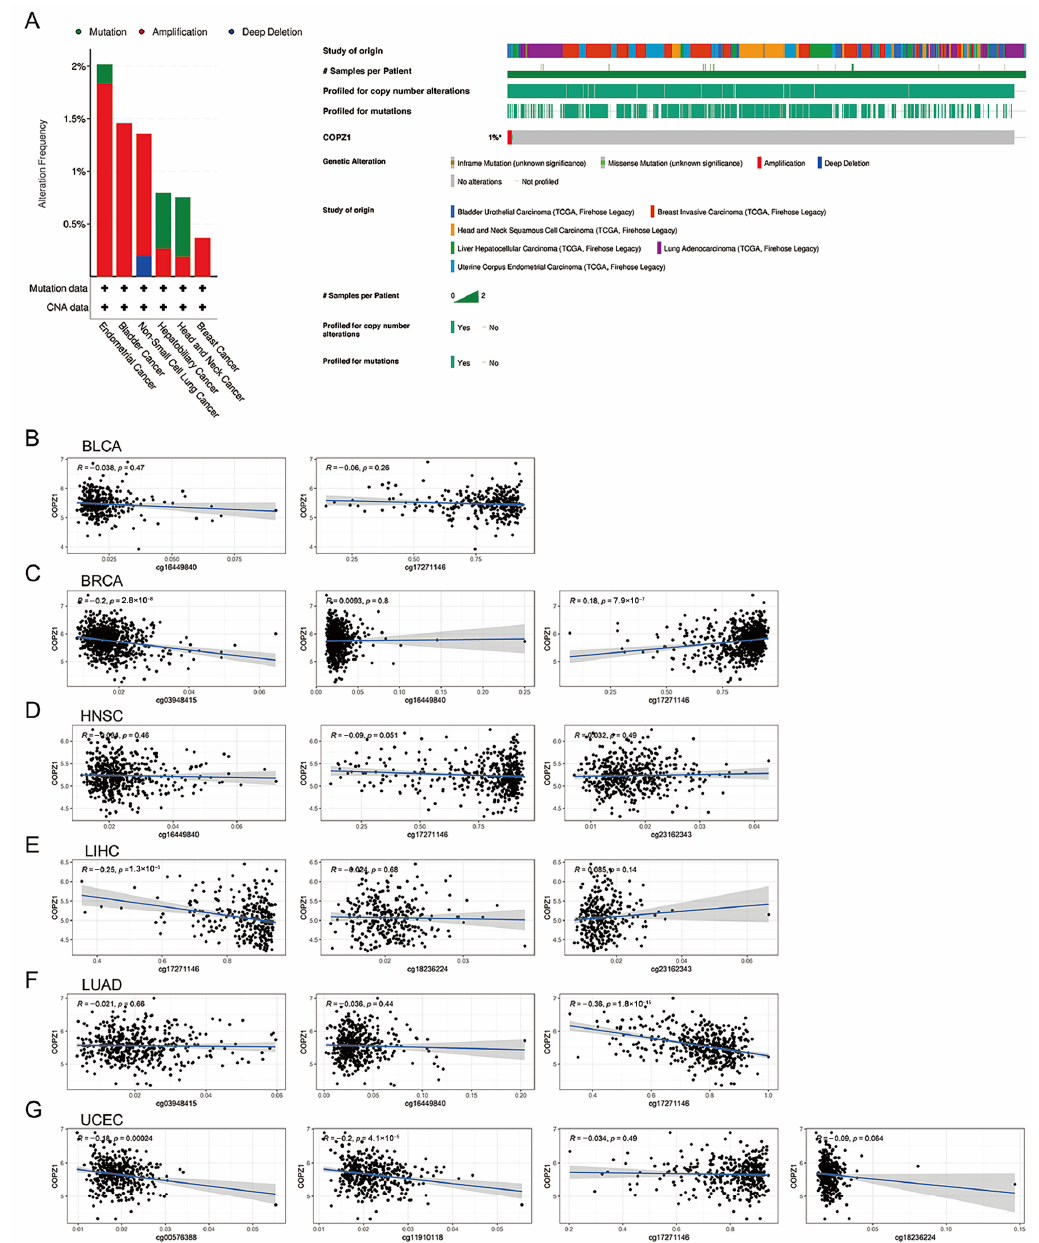
Figure 3. Genetic alterations and DNA methylation analysis of COPZ1 in cancers. ( A ). The alteration frequency and mutation type of COPZ1 were analyzed by the cBioPortal database. ( B – G ). The correlation of gene expression and DNA methylation of COPZ1 in six types of cancers.